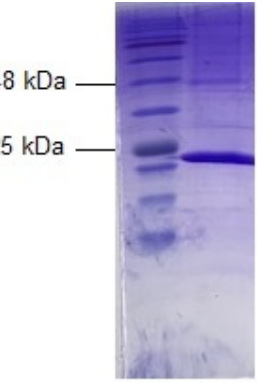
Figure 1. Analysis by SDS-PAGE of the purified dog GST P1-1 stained by Coomassie Brilliant Blue. The left lane shows molecular mass markers and the right lane the subunit of the purified